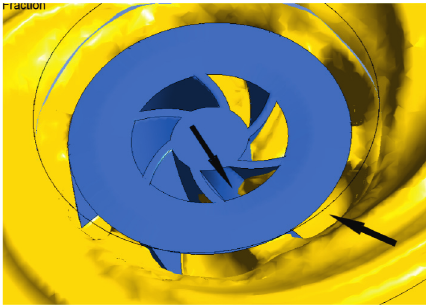
Figure 14: Air enters